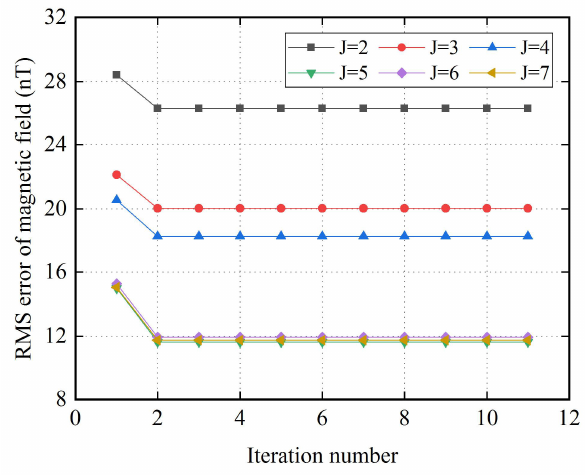
Figure 4. The RMS errors of magnetic field after each iteration when the highest order of harmonic terms J is set from 2 to 7.